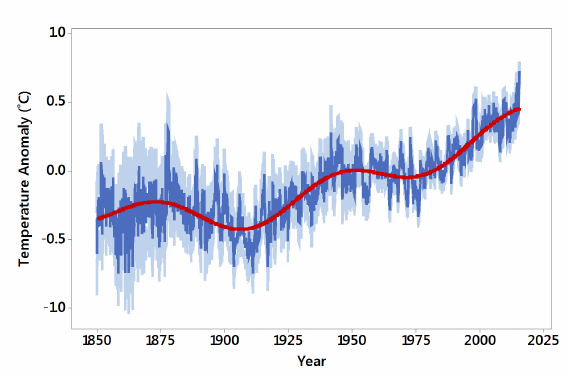
Figure 1: Hadley SST3 monthly averaged global temperature anoma- lies ( ∘ C) relative to 1961 – 1990 in dark blue with their uncertainties (in light blue) and the model representation in red, (Iz, 2016b).